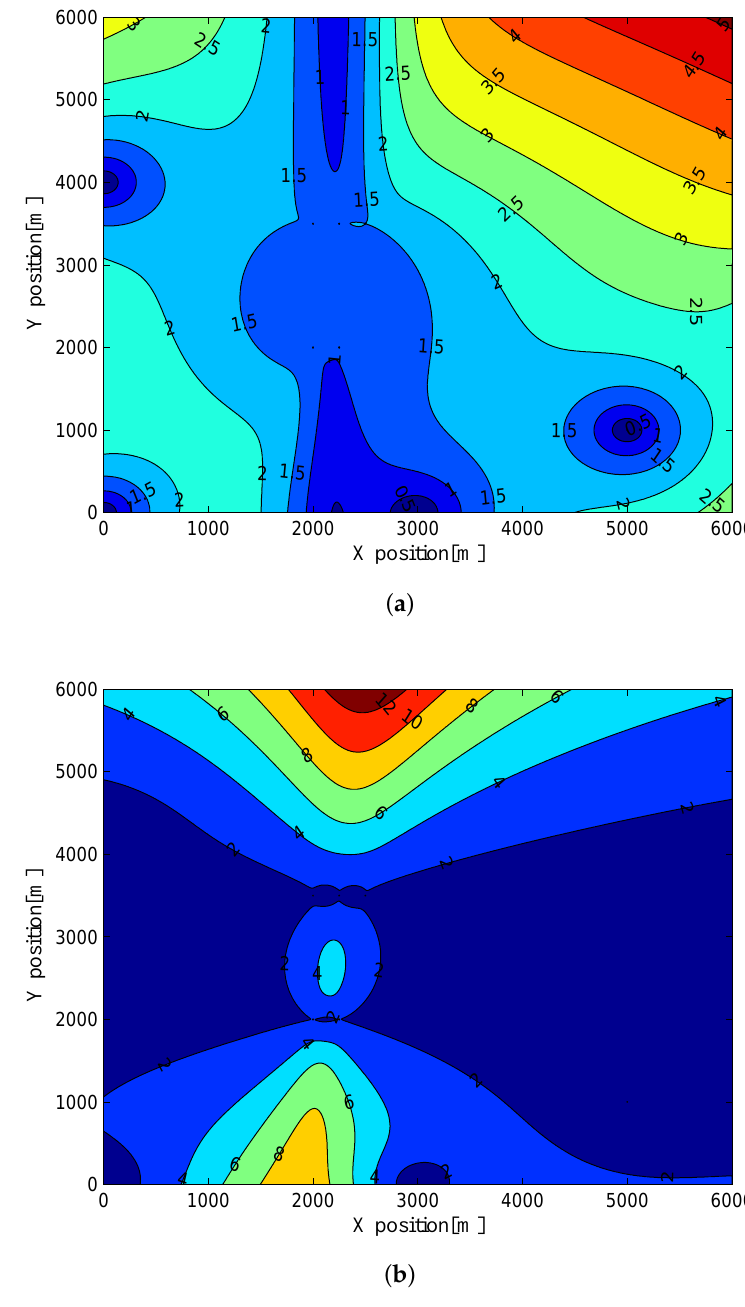
Figure 5. RMCRLB for target velocity dimensions in different position when SNR = 0dB and L r = 1000: ( a ) x-velocity; ( b )